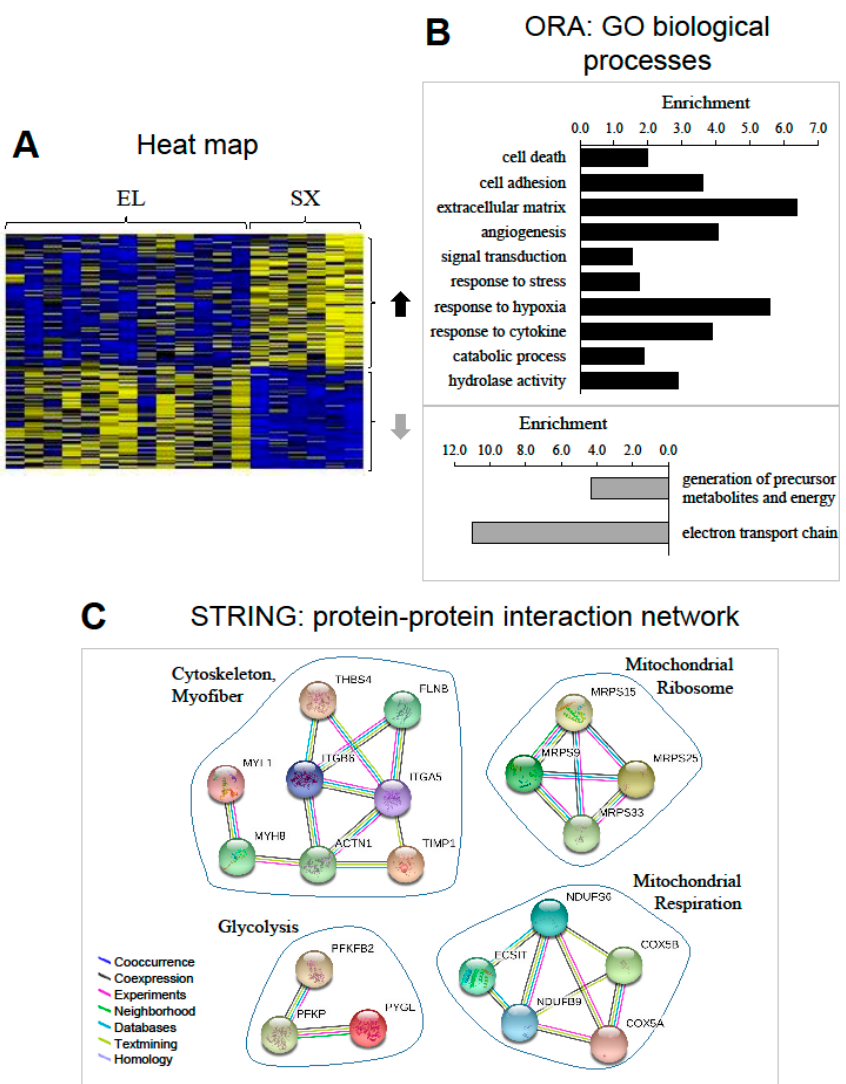
Figure 3. Transcriptomic profiling of metabolic syndrome in old men. ( A ) Heat map displaying the relative expression for genes differentially expressed with metabolic syndrome. Sixty-nine genes were upregulated, and forty-eight were downregulated with metabolic syndrome. The heat map depicts the relative expression of each probe set (row) for 13 healthy old men (EL) and 6 old men with metabolic syndrome (SX) (columns). The intensity of each block, either yellow (higher expression) or blue (lower expression), represents the magnitude of difference from the mean. ( B ) Over-representation analysis (ORA): top GO biological processes. The lists of genes upregulated (upper) and downregulated (lower) with aging were analyzed for enrichment of specific gene ontology (GO) terms. ( C ) Protein–protein interaction network represented by all genes differentially expressed with metabolic syndrome in old men. The interaction map was generated using STRING with high confidence of 0.7 and all criteria for linkage. The genes used in this network are listed in Table S1.